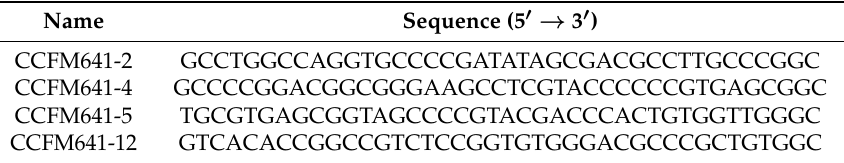
Table 1. Tested aptamer sequences a .